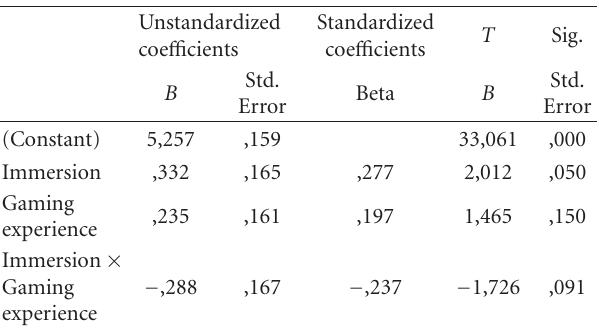
Table 7: Regression results.